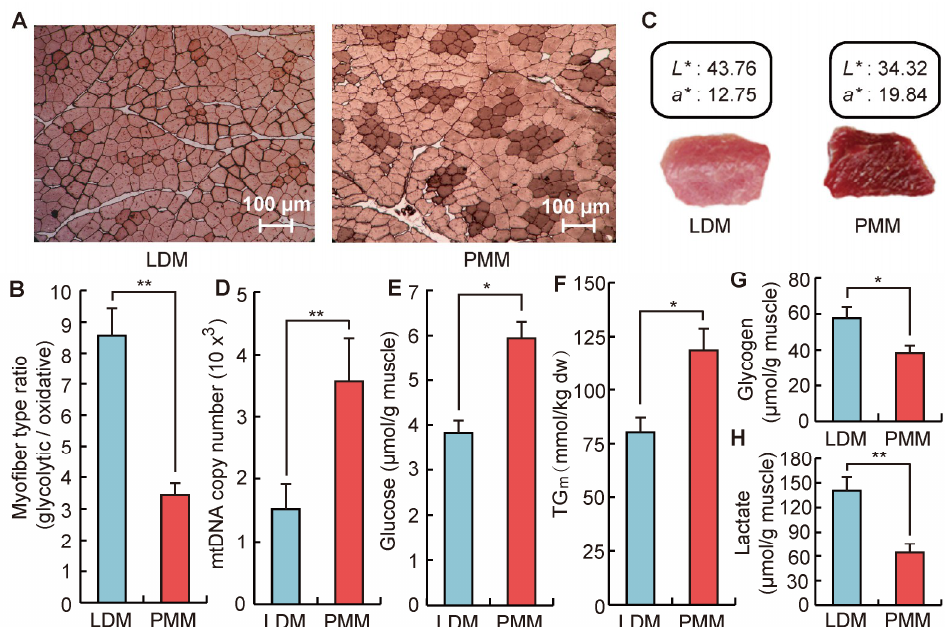
Figure 2. Di ff erent phenotypic indexes between oxidative (PMM) and glycolytic (LDM) skeletal muscles. ( A ) ATPase staining identifies slow-twitch (Type I) muscle fiber (dark color) and fast-twitch (Type II) muscle fiber (light color) in LDM and PMM, n = 8. ( B ) The muscle fiber types ratio (Fast / Slow) between LDM and PMM, n = 8. ( C ) The color of fresh samples of LDM and PMM, n = 8. ( D ) Mitochondrial DNA copy number per cell in LDM and PMM, n = 8. ( E – H ) The concentration of glucose, triglyceride, lactate, and glycogen in LDM and PMM, respectively, n = 8. Data are means ± SEM. Statistical significance was calculated by Student’s t -test. Significant di ff erence levels: * p < 0.05, ** p < 0.01.